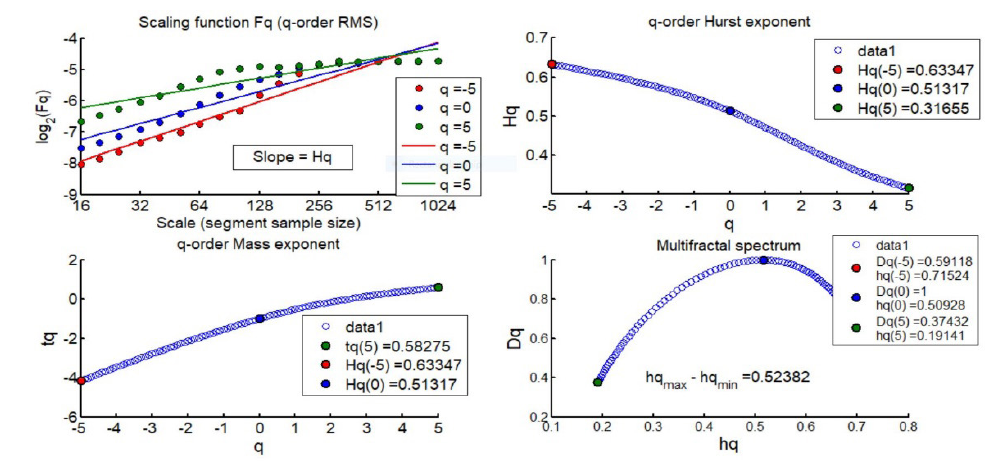
Figure A5. Hurst exponent value Hq(5) in 2015